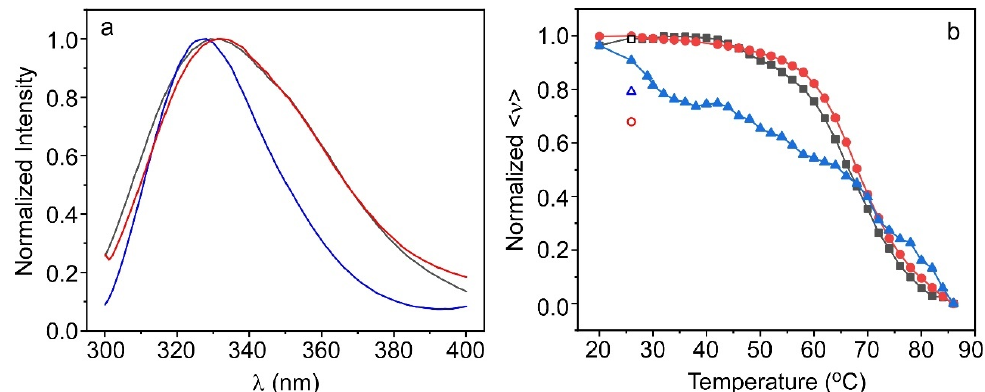
Figure 2. ( a ) Normalized fluorescence emission spectra recorded at room temperature ( λ x = 290 nm) and ( b ) evolution with temperature of the normalized mean fluorescence energy < ν > of ALP in solution (black), immobilized in situ (blue) and ex situ (red) in AETA hydrogels. < ν > values at 25 °C recorded after heat treatment are shown as empty symbols.